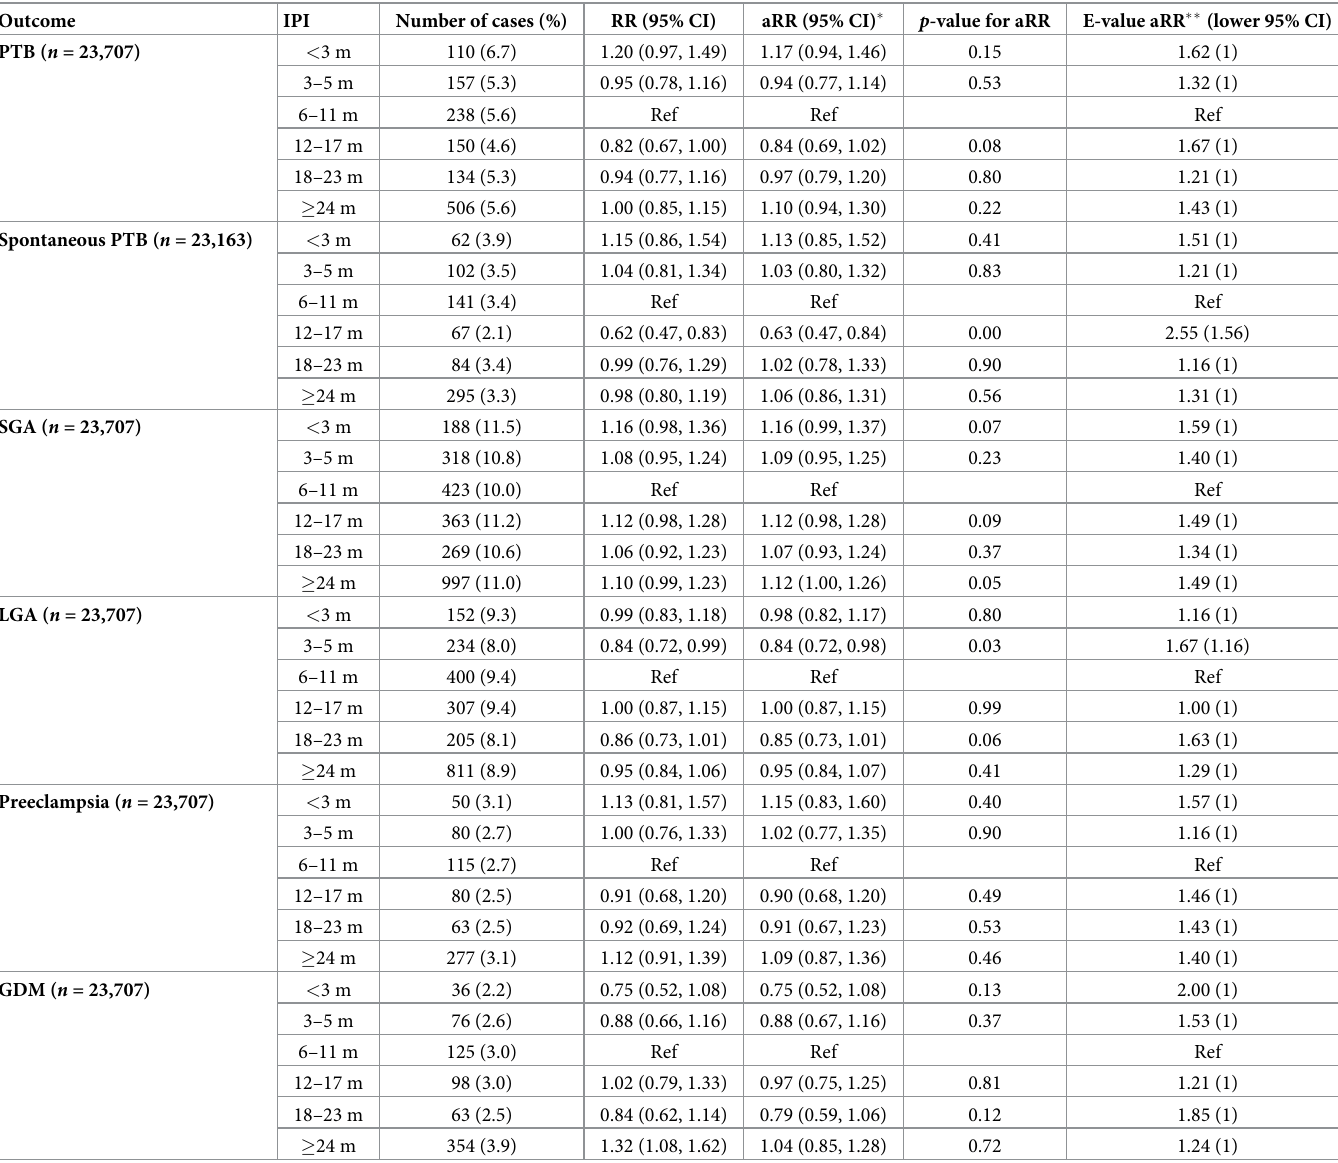
Table 4. IPI after previous induced abortion and risk of adverse pregnancy outcomes for births between 2008 and 2016 in Norway ( n = 23,707). Outcome